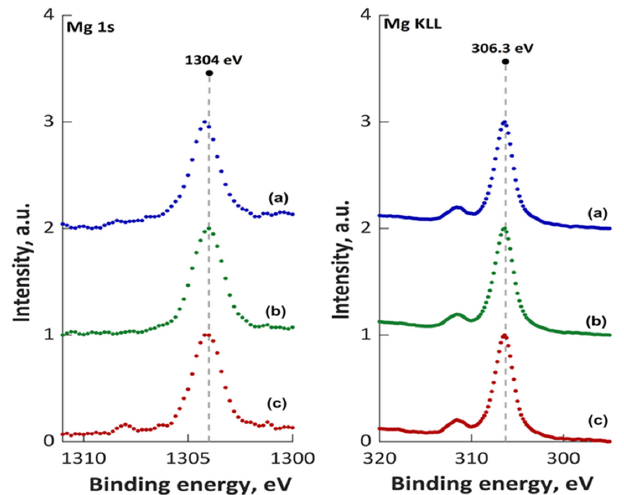
Figure 12. XPS high resolution spectra of Mg 1 s and Mg KLL of 10 MgHApCh-0 ( a ), 10 MgHApCh- 3 ( b ), and 10 MgHApCh-6 ( c )